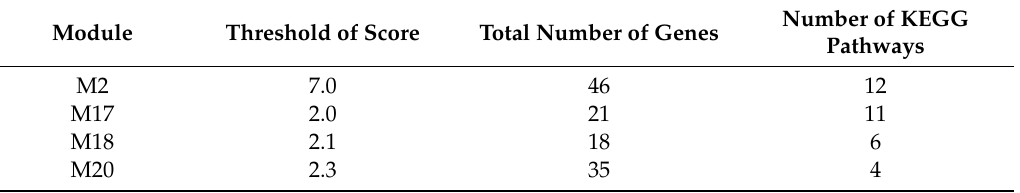
Table 2. KEGG pathway enrichment of conserved first-order genes of modules in the blood TSPPI network.